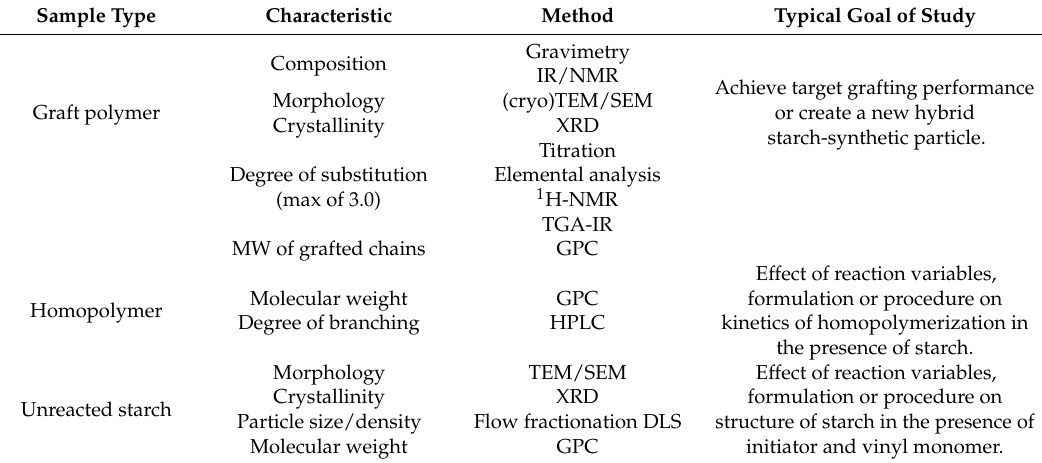
Table 3. Common characterization methods for each component of a starch graft